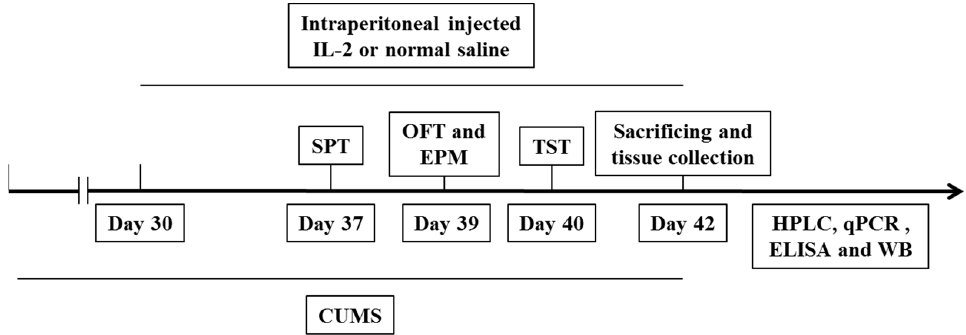
Figure 9. Experimental procedures. CUMS, chronic unpredictable mild stress; SPT, sucrose preference; OFT, open field; EPM, elevated plus maze; TST, tail suspension tests; HPLC, high-performance liquid chromatography; qPCR, quantitative real-time polymerase chain reaction; ELISA, Enzyme-linked immunosorbent assay; WB, Western